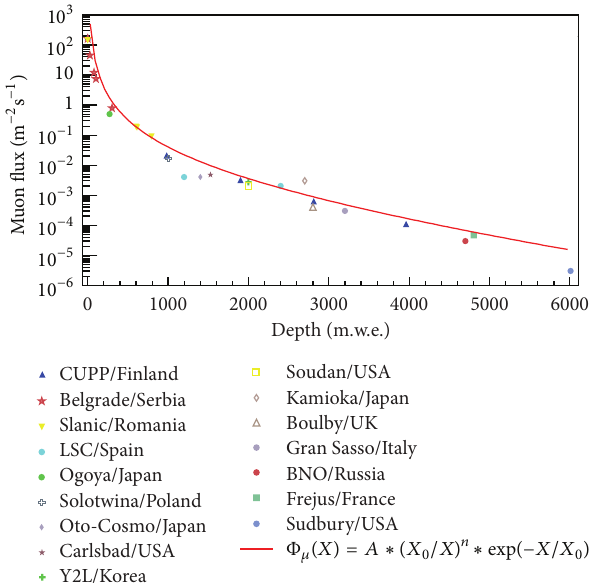
Figure 6: The variation of flux as function of mwe depth for the results presented in Table